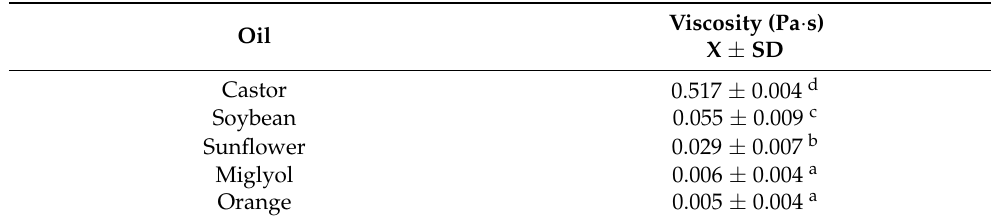
Table 1. Viscosities of the oils.